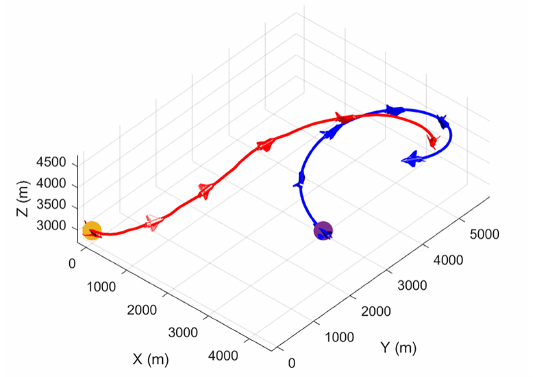
Figure 15. The two UCAV tracks in the later training period in case 2.